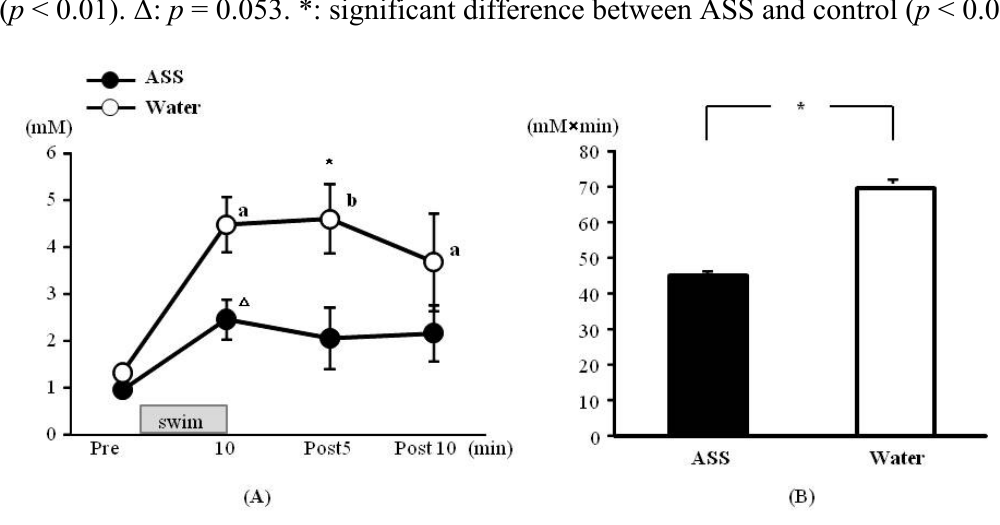
Figure 3. Changes in the blood lactate on swim exercise. ( A ) time course change, x axis: elapsed time on swimming, y axis: blood lactate concentration ( B ) area under the curve of blood lactate acid, x axis; group, y axis: total volume of blood lactate. Values are expressed as mean ± SE. a: significant difference from rest ( p < 0.05). b: significant difference from rest ( p < 0.01). Δ : p = 0.053. *: significant difference between ASS and control ( p <